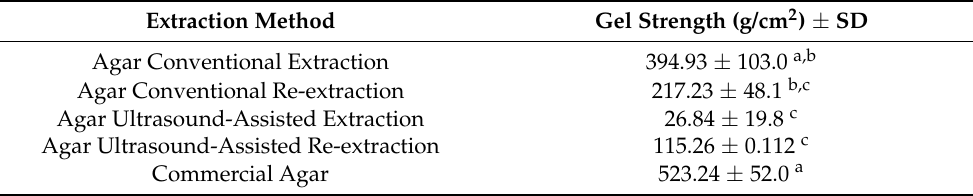
Table 7. Gel strength values of the agar extracted by different optimized methods.